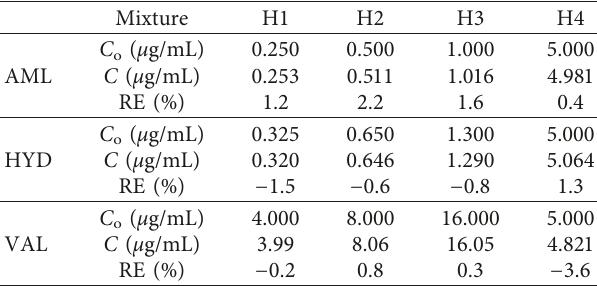
Table 4: Quantification results of AML, HYD, and VAL in a mixture using the Kalman filter with the selection of the ap- proximate initial guesses